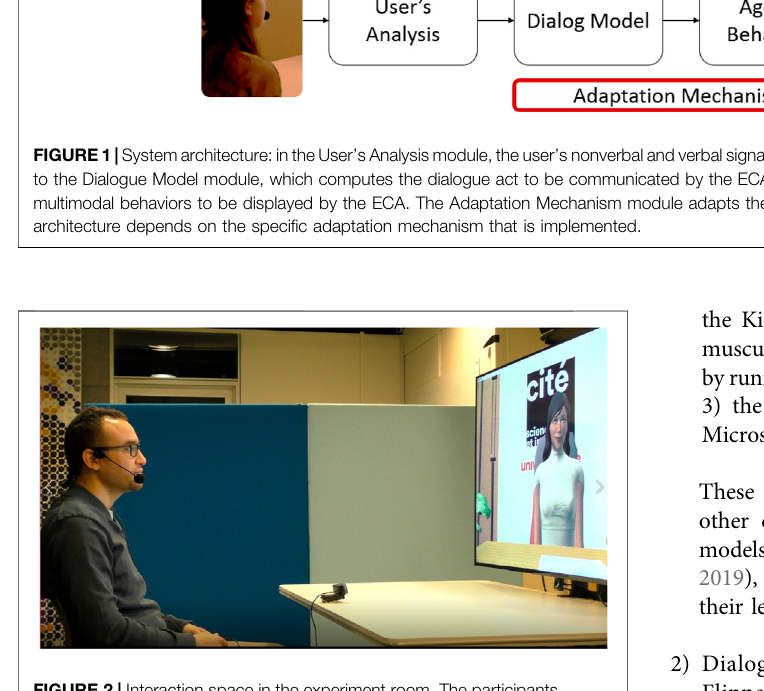
FIGURE 2 | Interaction space in the experiment room. The participants were sitting in front of the TV screen displaying the ECA. On the left, two screens separated the interaction space from the control